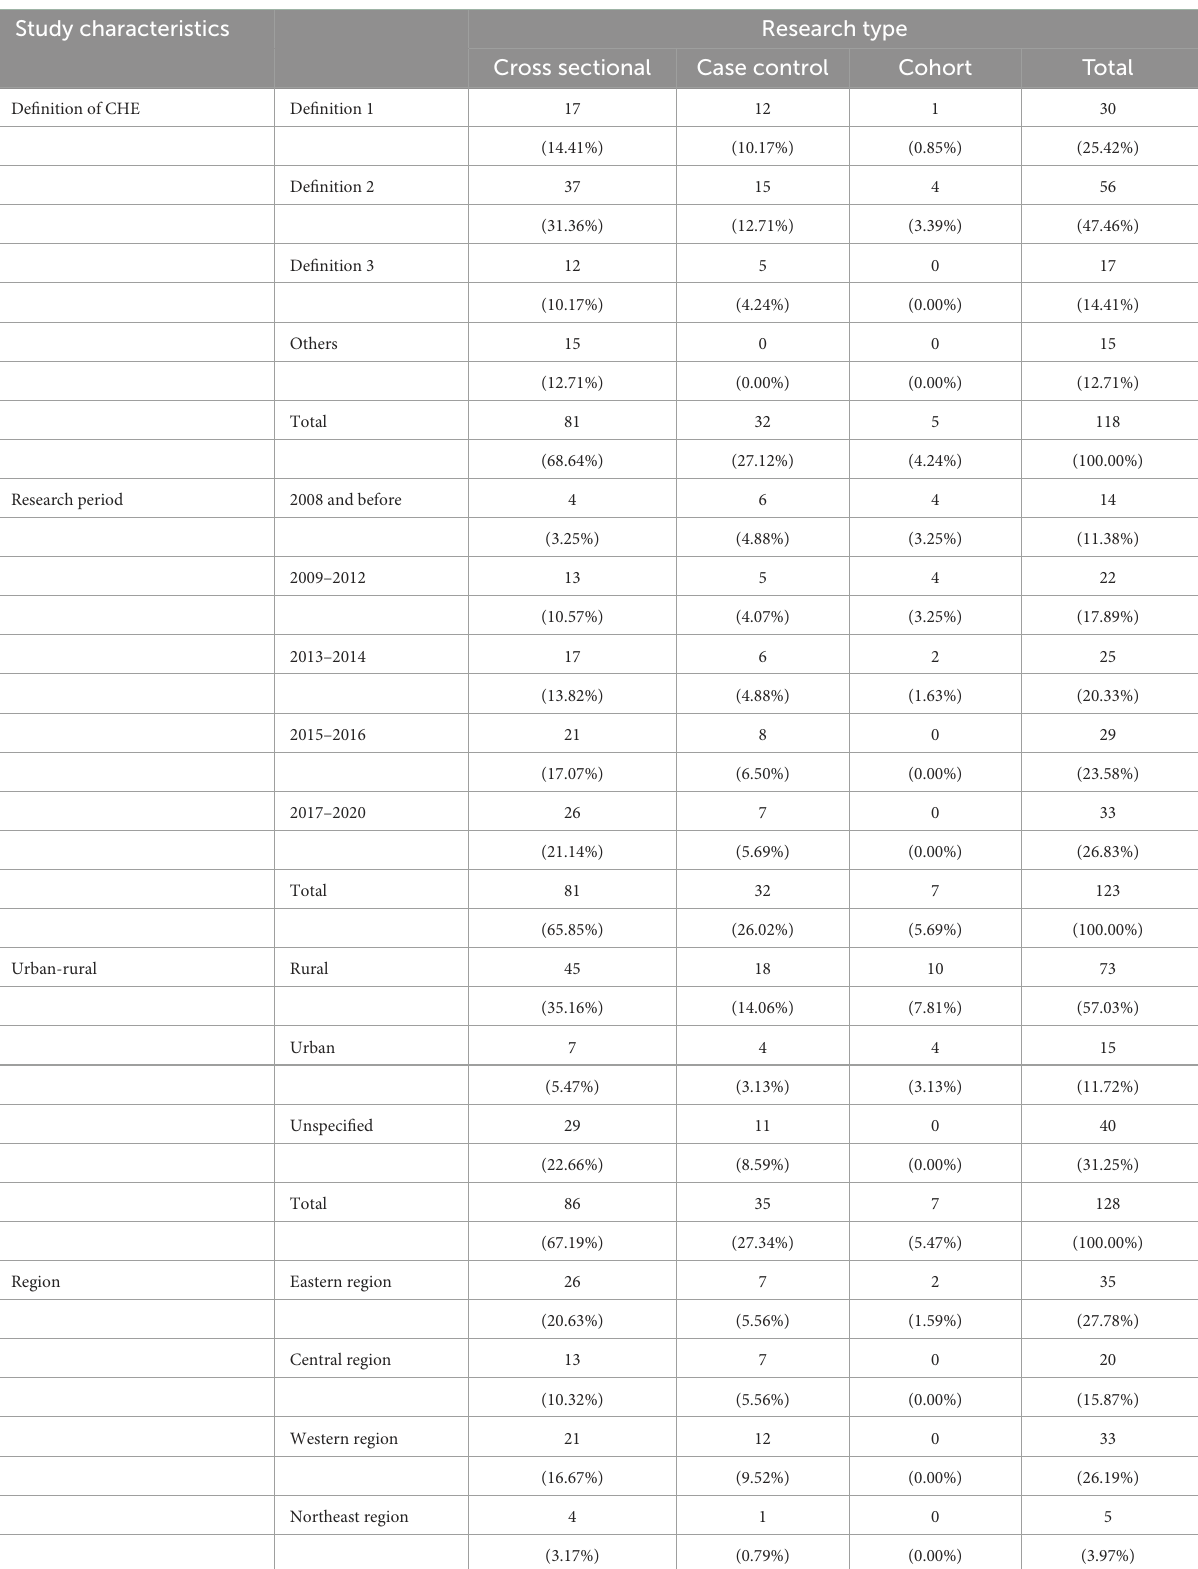
TABLE 1 Summary of characteristics of included studies [ n ,